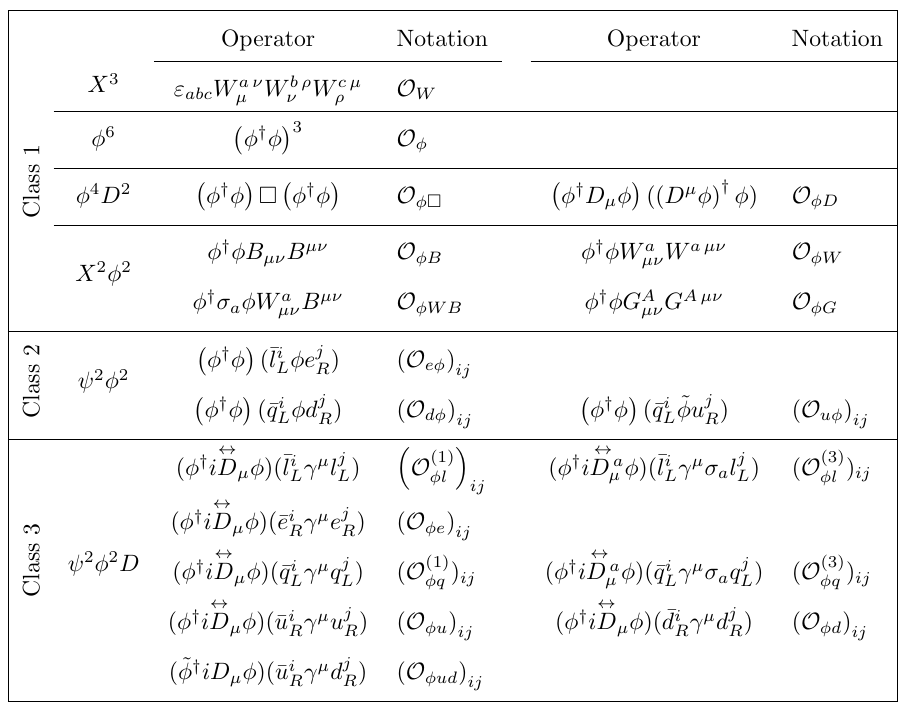
Table 6 . Dimension six operators considered in the SMEFT analysis. The hermitian derivatives $ D and $ D a are de(cid:12)ned as: $ D (cid:22) (cid:17) ! D (cid:22) (cid:0) D (cid:22) and $ D a denote the SM gauge boson (cid:12)eld-strengths. See text for details. Apart from these, the e(cid:11)ects of the four-lepton operator ( O ll ) 1221 = decay amplitude, must also be included in the (cid:12)t since we use the Fermi constant as one of the SM input